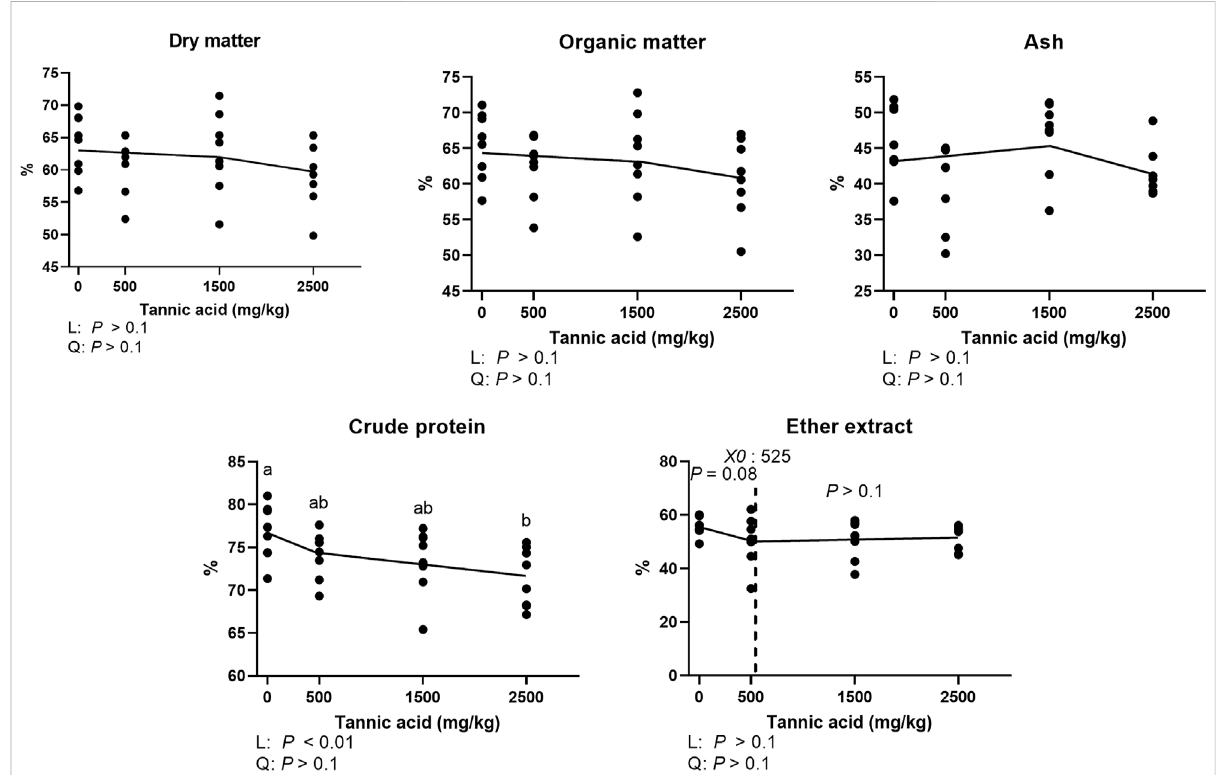
FIGURE 2 Apparent ilealdigestibility ofdrymatter,organic matter,ash,crude protein,etherextract inbroilerchickensfeddifferentconcentrations(0,0.5, 1.5,and2.5 g/kg)oftannicacidonD21.Thetreatmentgroupswerecomparedusingone-wayANOVAfollowedbytheTukey ’ smultiplecomparison. Different superscripts differ at p < 0.05. Orthogonal polynomial contrasts analysis was conducted to see linear pattern (L) and quadratic pattern (Q) among the treatments. To calculate the optimal dosage of tannic acid in broilers, segmented linear regression was conducted, and X0 (in fl ection point) with p values for slope 1 (lower than X0 ) and slope 2 (higher than X0 ) were